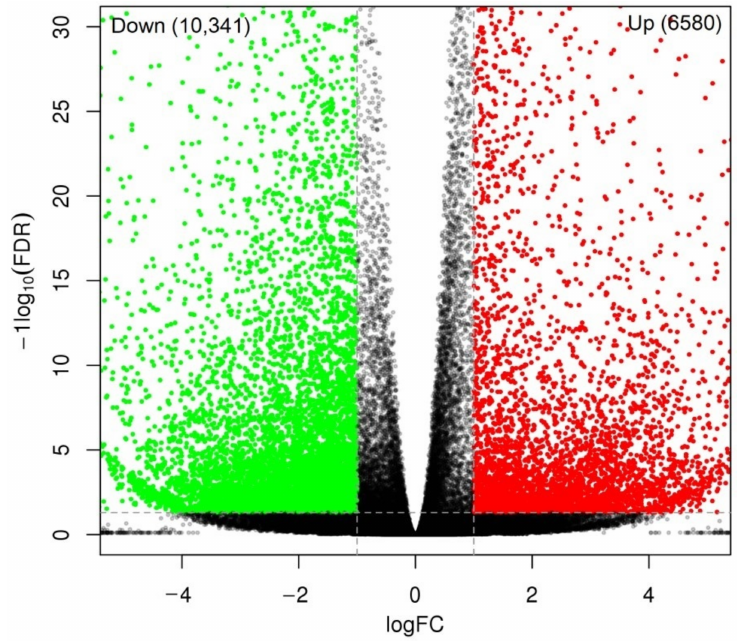
Figure 6. Volcano plot of unigenes and number of differentially expressed genes (DEGs) in the CR compared with